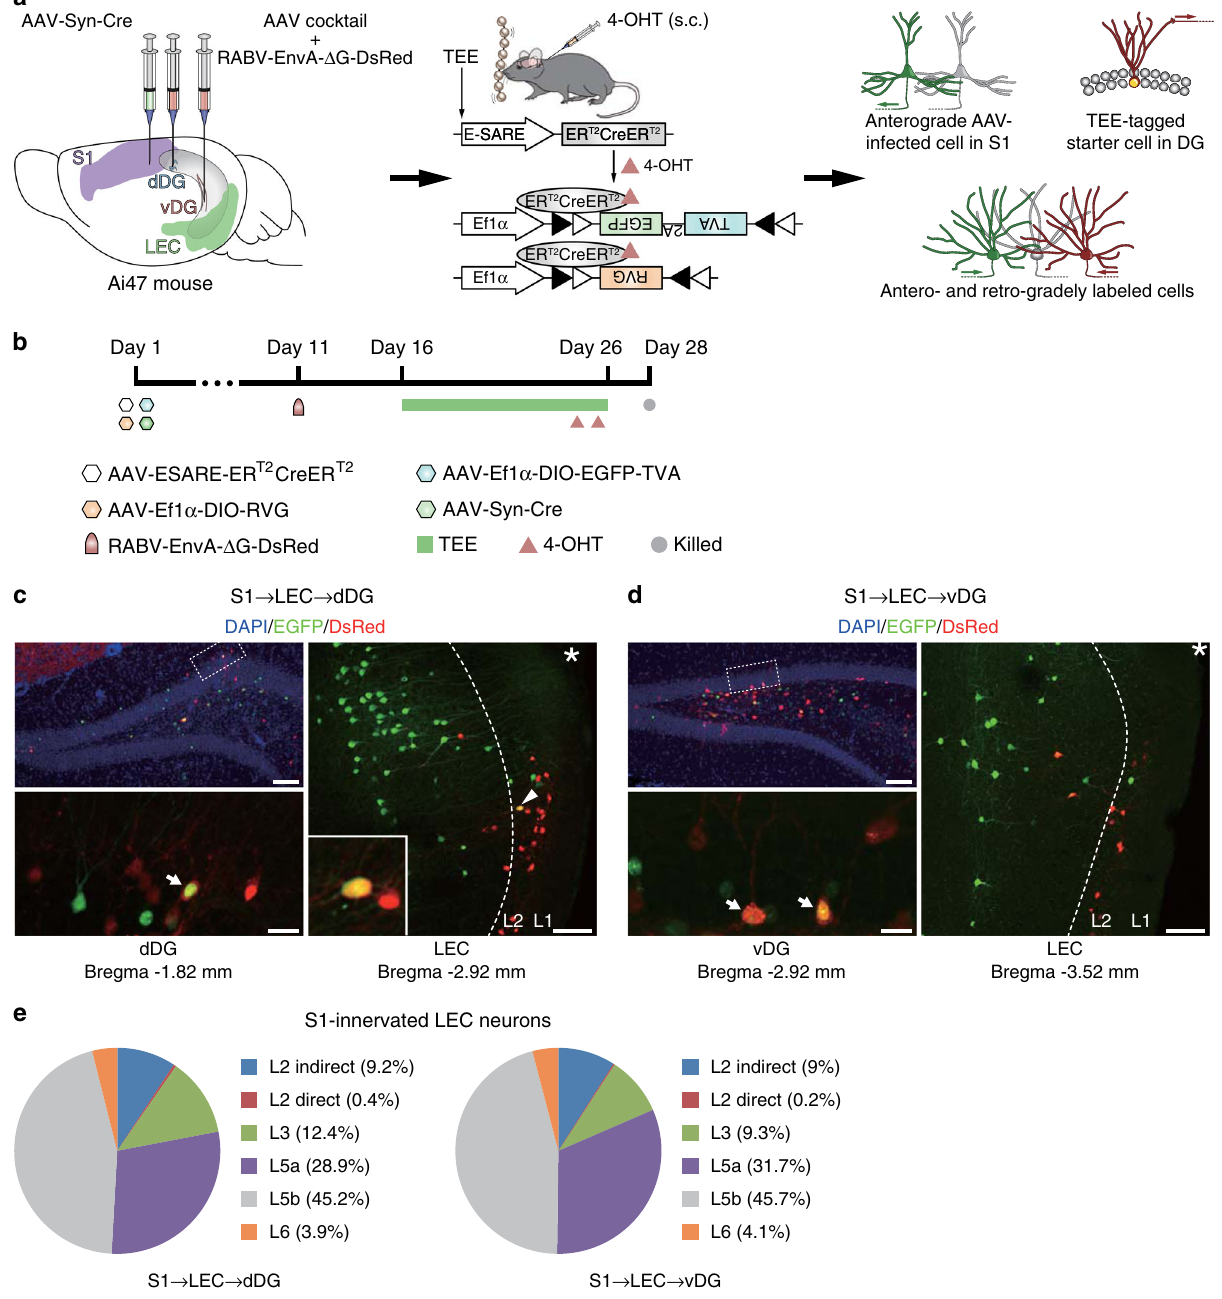
Fig. 5 Transsynaptic tracing of S1-innervated LEC cells that project to TEE-tagged DG neurons. a Illustration of the strategy for simultaneous anterograde and retrograde monosynaptic tracing. b The timeline of experiment. n = 3 and 2 mice for dDG and vDG experiments respectively. c , d Upper left panels show DG cells stained by DAPI, EGFP and DsRed. Boxed regions were imaged at a higher magni fi cation and are presented in lower left panels, where arrows indicate EGFP and DsRed double-labeled starter cells. Right panels show anterogradely labeled S1-innervated cells (EGFP + ) and retrogradely labeled ( c ) dDG- or ( d ) vDG-projecting cells (DsRed + ) in the LEC. The arrowhead indicates an LEC layer 2 cell (magni fi ed in the inset) that both received S1 input and projected to TEE-tagged dDG neurons. Scale bars are 100 μ m for upper left and right panels and 20 μ m for lower left panels. Asterisks indicate the rhinal fi ssure. e Pie charts depict the percentage of S1-innervated LEC layers 2 – 6 neurons that indirectly or directly targeted TEE-tagged dDG and vDG neurons. Source data are provided as a Source Data fi